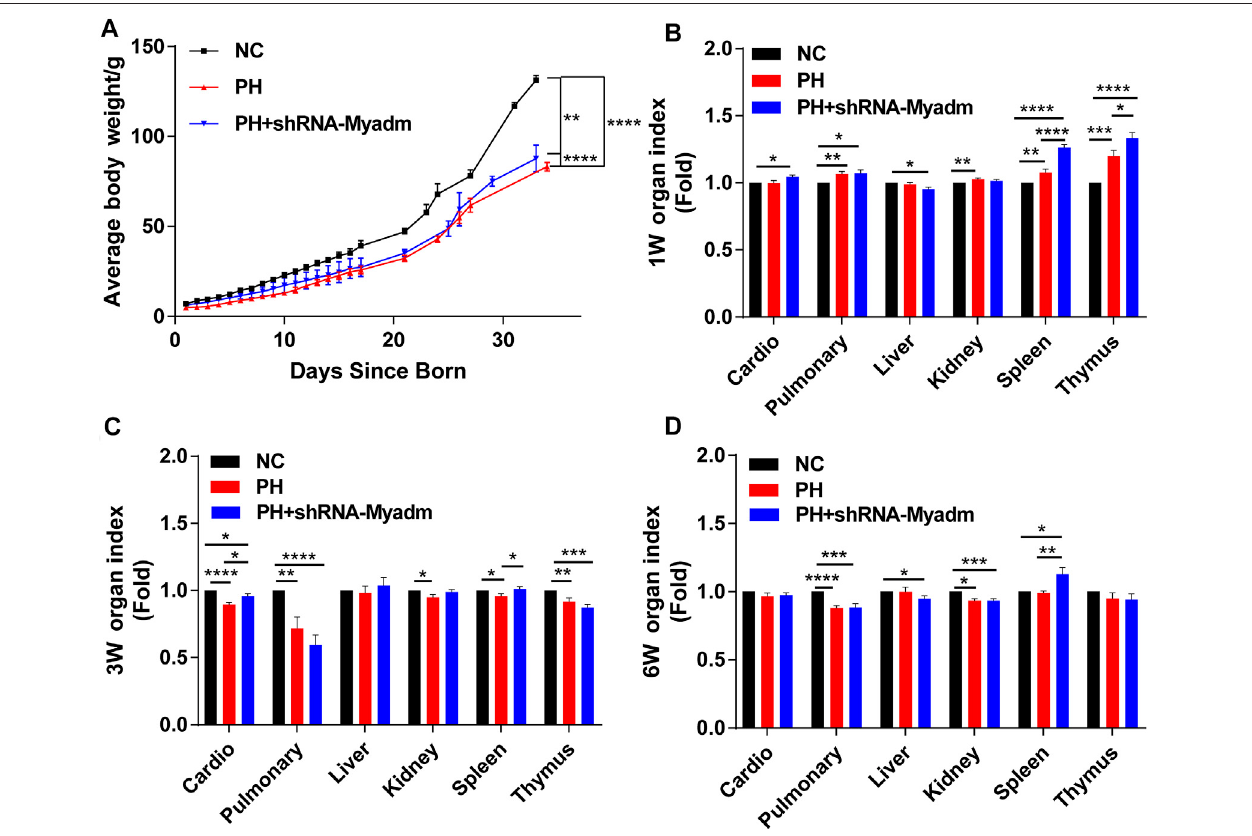
FIGURE 8 | Growth of rat offspring in normal, maternal PH, and intervention groups. (A) The growth of body weight (mean ± SD) in each group was analyzed by paired Student ’ s t test. (B) Organ index of offspring in each group at 1 week of age. (C) Organ index of offspring in each group at 3 weeks of age. (D) Organ index of offspring in each group at 6 weeks of age. * p < 0.05, ** p < 0.01, *** p < 0.001, **** p < 0.0001 vs. the normal pregnancy group ( n (cid:1) 6 rats per group). NC, normal control; PH, pulmonary